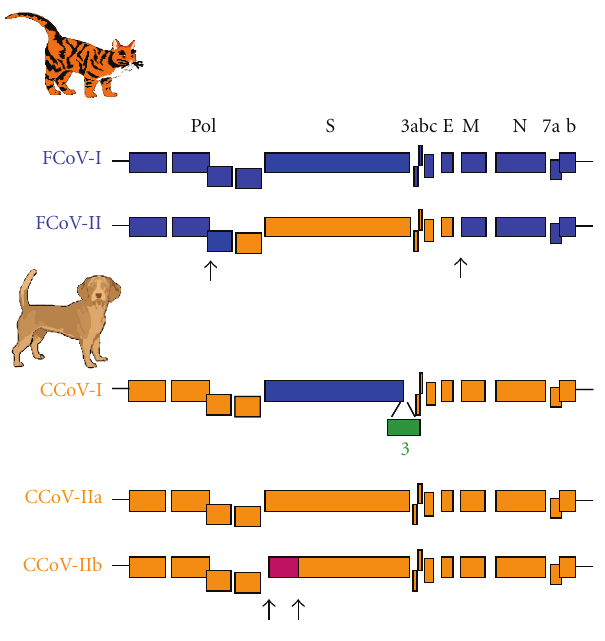
Figure 1: Genetic relationships between the di ff erent feline and canine coronaviruses genotypes (FCoV and CCoV). The feline sequences are coloured in blue, the canine sequences in orange, and the porcine sequences in purple. Arrows indicate the putative sites of recombinations. The genes encoding for the polymerase polyprotein (pol), the structural spike (S), the envelope (E), the membrane (M), and the nucleocapsid (N) proteins are indicated. The genes encoding the accessory proteins are designated by